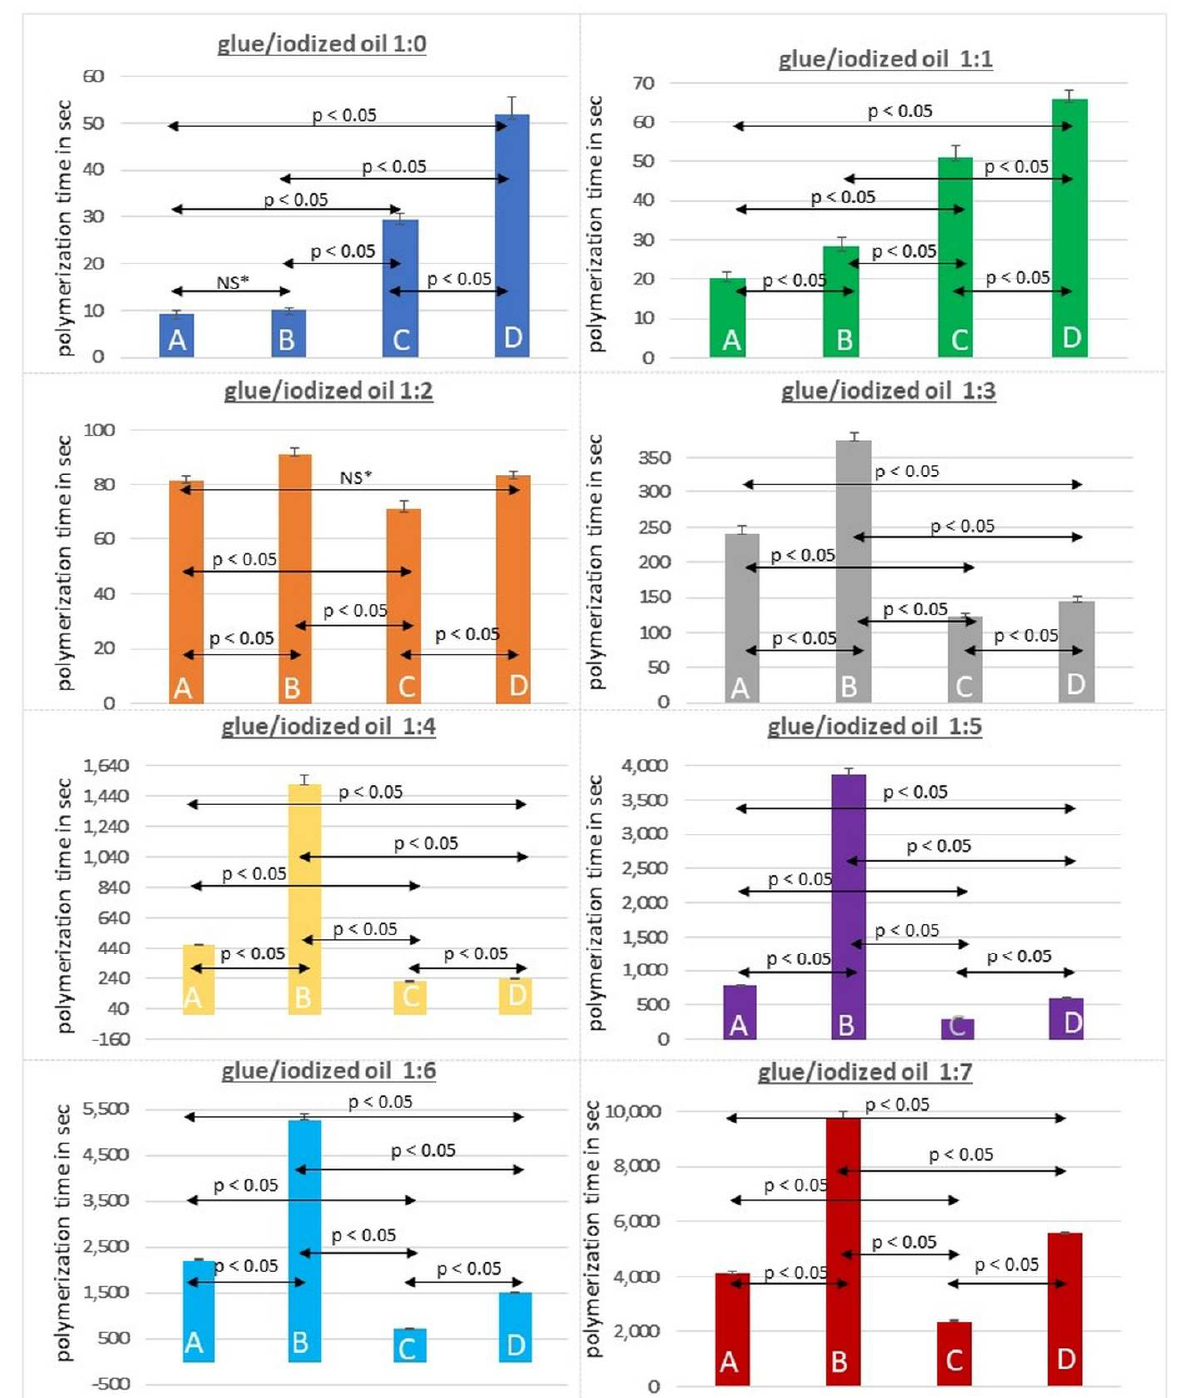
Figure 3. Polymerization times in seconds for HA (A & B) and GL (C & D) mixed with iodized oil (ratios 1:0 to 1:7) in low triglyceride fluid (low TG; < 50 mg/dl) (A & C) and high triglyceride fluid (high TG; > 600 mg/dL) (B & D). Arrows indicate results of intergroup comparison of total polymerization times using the Kruskal–Wallis test (one-way analysis of variance) and the Conover test (post hoc analysis). Polymerization times of pure HA (ratio 1:0), as well as high concentration HA (ratio 1:1), were significantly shorter than those of GL (Group A vs. C; Group B vs. D). For all other comparisons (ratios 1:2 to 1:7) GL showed significantly shorter polymerization times. NS* indicates non-significant results.